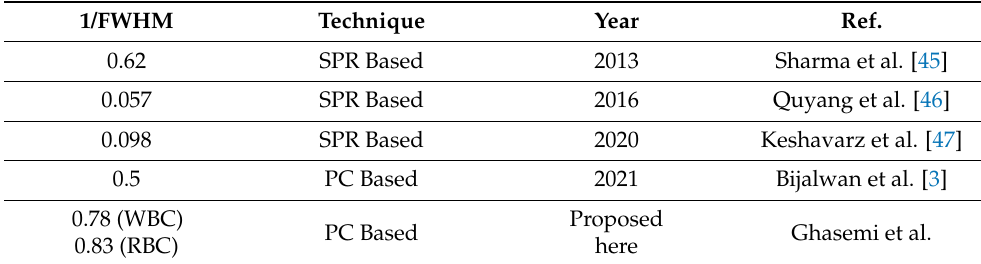
Table 3. Comparison of the suggested sensor performance with the results of the previous